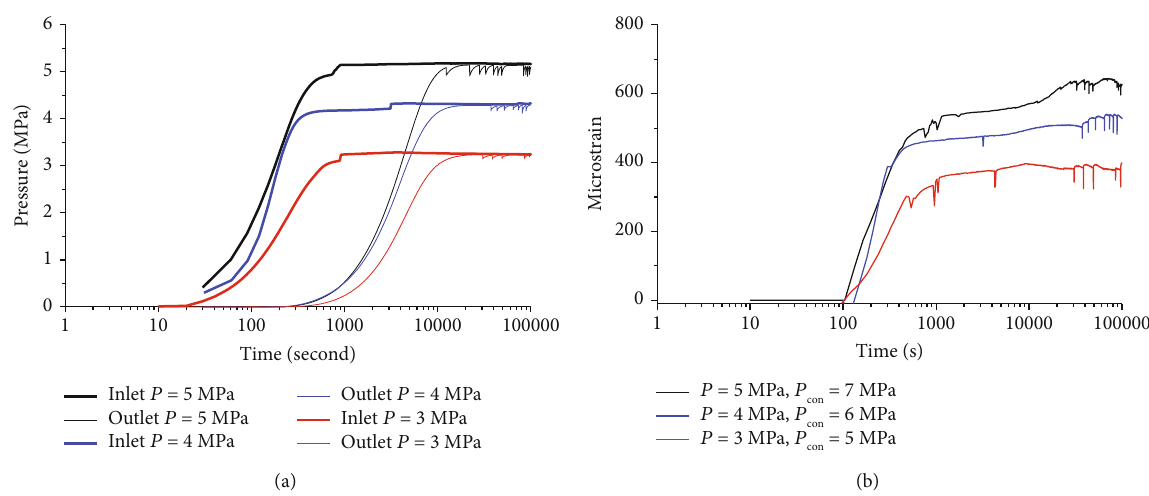
Figure 5: Experimental results under constant di ff erence pressure condition. (a) Gas pressure data of upstream/downstream reservoirs; (b) circumference strain of the coal sample.